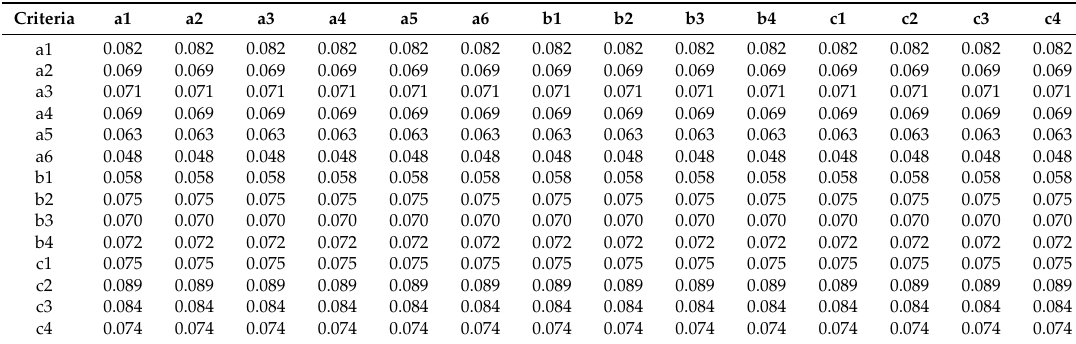
Table 15. Limit of the weighted super-matrix.